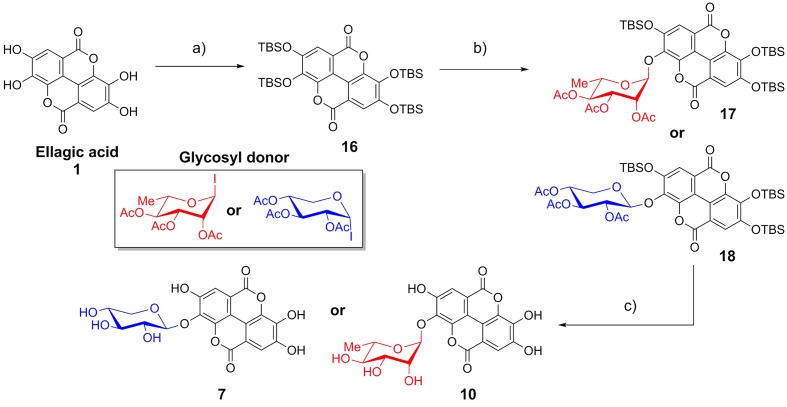
Synthesis of ellagic acid glycosides. (a) TBSCl, Im, DMAP, CH2Cl2/DMF, 50°C, 36 h, 71%; (b) TASF, CH2Cl2, room temperature, 10 min; then glycosyl donor, Bu4NI (xyloside only), reflux, 48 h, 13–15%. (c) (1) K2CO3, DMF/H2O; (2) K2CO3, MeOH/H2O, 86–92%.